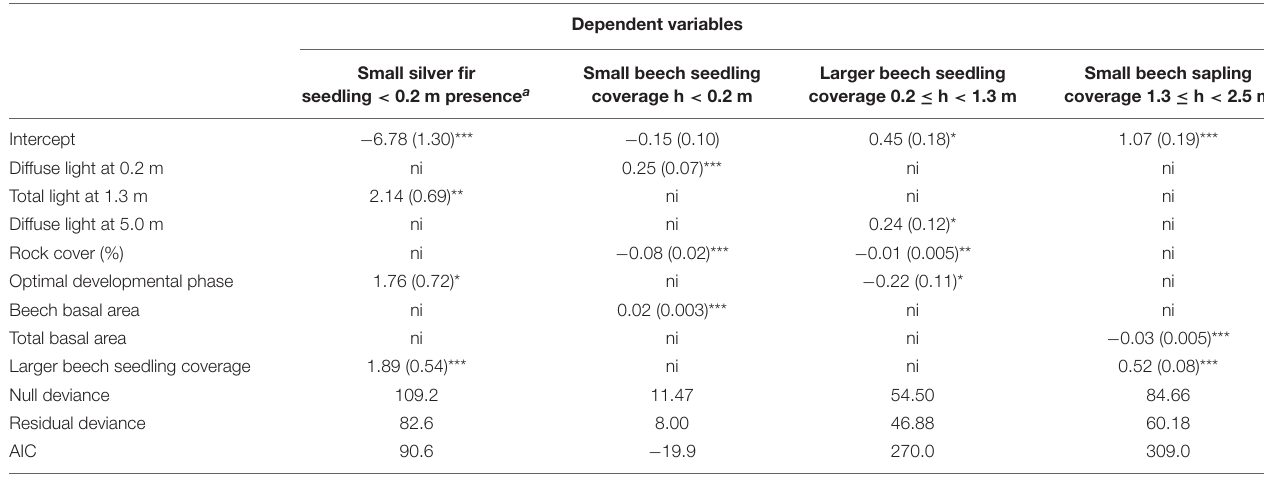
TABLE 2 | Results of the GLM analysis for silver fir presence (h < 0.2 m) and beech seedling and sapling cover predicted by light components, rock cover, developmental phase, beech basal area, and beech seedling coverage for 164 regeneration plots. Dependent